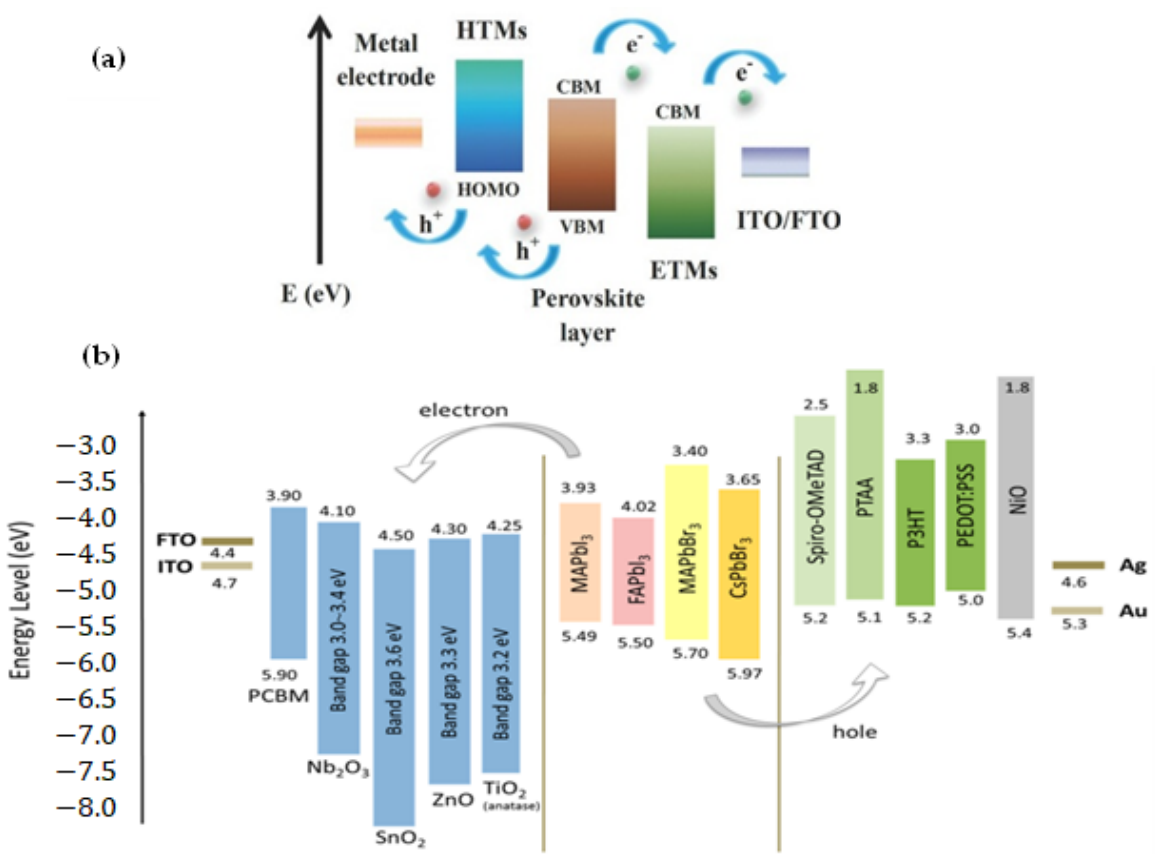
Figure 9. ( a ) Schematic diagram showing the basic device operation in a PSC. ( b ) Simplified energy alignment of possible ETM and HTM materials in PSC applications [19,60].